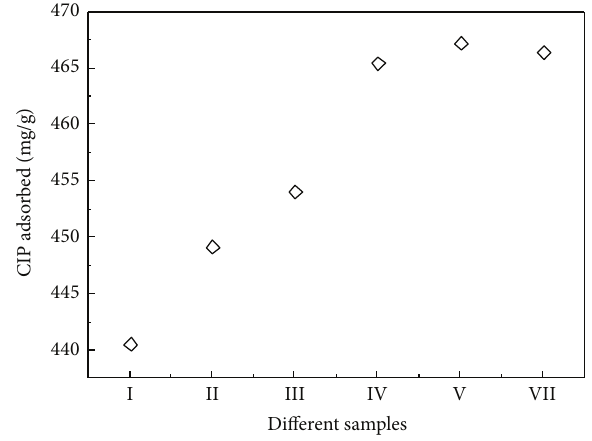
Figure 7: CIP adsorption on birnessite samples of different MnCl 2 /KMnO 4